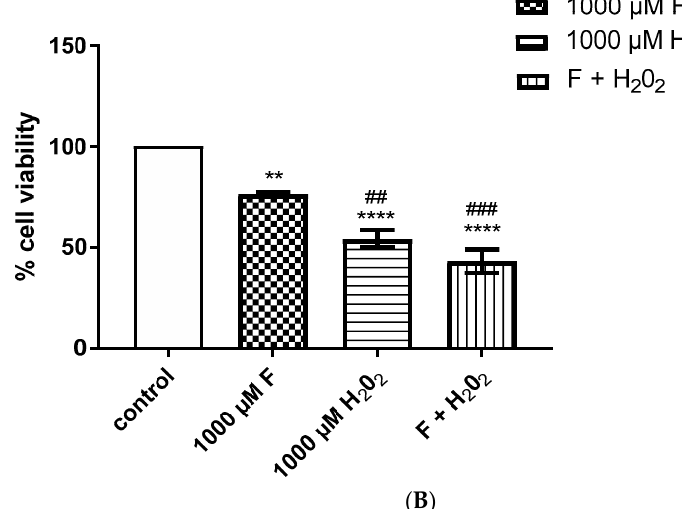
Figure 2. Direct cytotoxic effect was detected from SSAO’s derived products methylglyoxal, formaldehyde and H 2 O 2 , expressed as percentages of cell viability (MTT assay). VSMCs were treated with methylglyoxal (MG), formaldehyde (F), H 2 O 2 , and the combination of both (MG + H 2 O 2 ) and (F + H 2 O 2 ). For ( A ) ** p < 0.01 for 50 µM MG vs. control, *** p < 0.001 for 50 µM H 2 O 2 vs. control, **** p < 0.0001 for 50 µM MG + H 2 O 2 vs. control (one-way ANOVA followed by Dunnett’s), ### p < 0.001 for 50 µM MG + H 2 O 2 vs. 50 µM MG; ## p < 0.01 for 50 µM MG + H 2 O 2 vs. 50 µM H 2 O 2 (one-way ANOVA followed by Tukey’s). For ( B ) ** p < 0.01 for 1000 µM F vs. control, **** p < 0.0001 for 1000 µM H 2 O 2 vs. control and **** p < 0.0001 for 1000 µM F + H 2 O 2 vs. control (one-way ANOVA followed by Dunnett’s); ## p < 0.01 for 1000 µM H 2 O 2 vs. 1000 µM F; ### p < 0.001 for 1000 µM F + H 2 O 2 vs. 1000